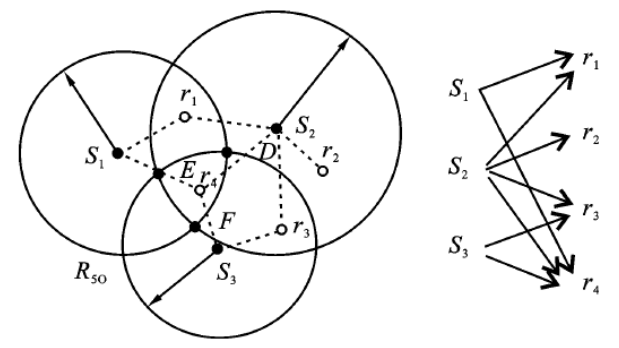
Figure 6. Node coverage of wireless sensor network.